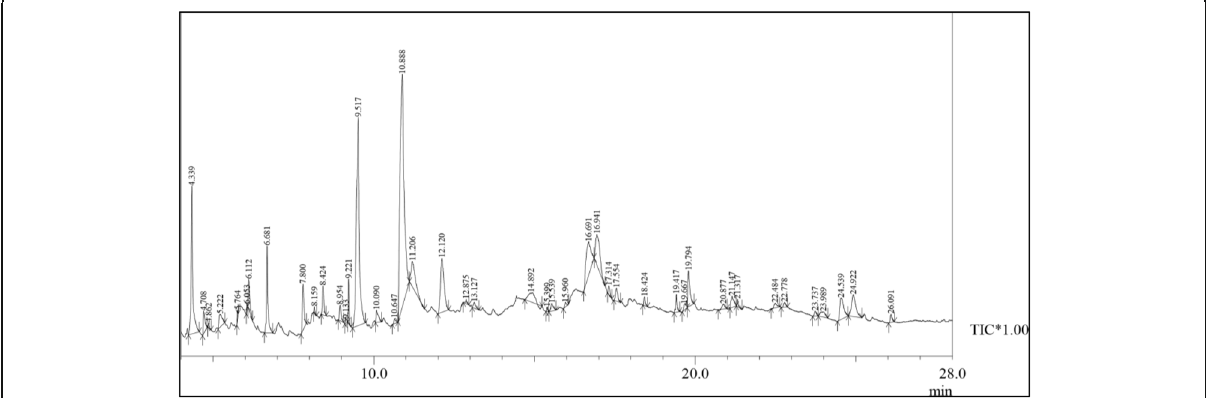
Fig. 4 GC-MS chromatogram of fermented tea petal decoction